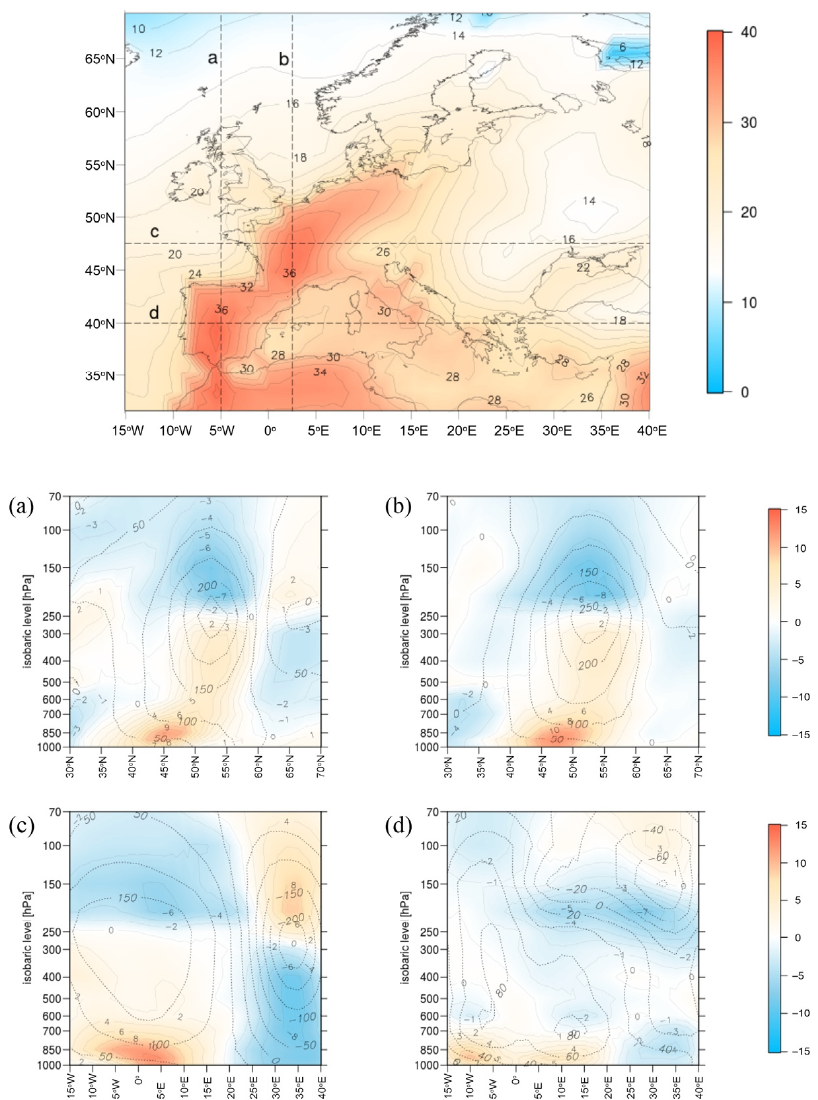
Figure 11. Map of air temperature at 2 m (°C) (upper map); air temperature anomalies (°C) (colour scale) and geopotential height anomalies (m) (dotted lines) in troposphere alongside 5 °W ( a ) and 2.5 °E ( b ) meridians, and 47.5 °N ( c ) and 40 °N ( d ) parallels, 12 August 2003.